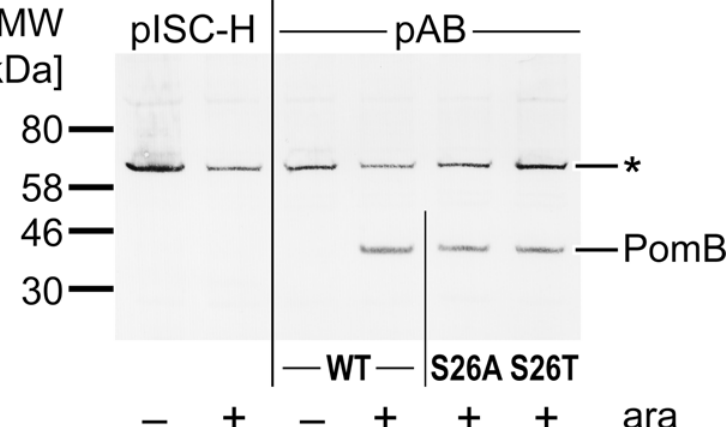
Fig 3. Expression levels of plasmid-encoded PomB variants in V . cholerae Δ pomAB . Wild type PomB-Strep, PomB-S26A-Strep and PomB-S26T-Strep were detected in extracts from V . cholerae Δ pomAB cells transformed with variants of plasmid pAB on a Western blot. PomB-Strep with an apparent molecular weight around 46 kDa was expressed in the presence (+) but not in the absence ( ‒ ) of 10 mM L-arabinose, and it was also absent in extracts from V . cholerae Δ pomAB transformed with the empty vector (pISC-H). Cells were grown for 4 h at 30°C, harvested and resuspended in SDS loading buffer to a final OD 600 of 5.0. Per lane, an aliquot of 18 μ g total cell protein was loaded. The bands ( * ) above the 58 kDa marker result from detection of an endogenous, biotinylated protein of V . cholerae by the Strep-Tactin-horseradish peroxidase conjugate